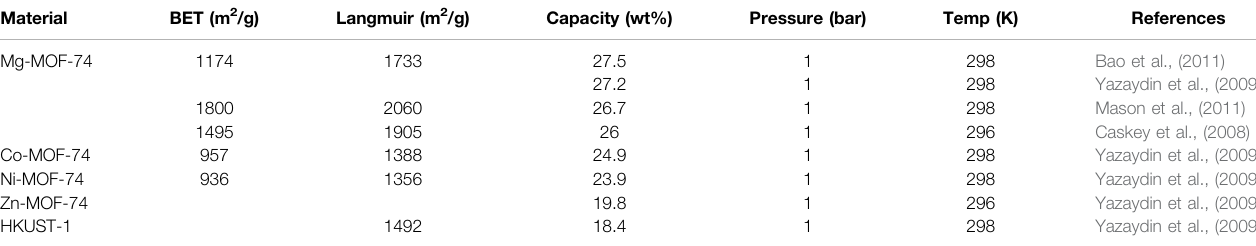
TABLE 5 | Comparison of CO 2 adsorption performance of common adsorbent materials under low pressure (Li et al., 2020b). Material BET (m 2